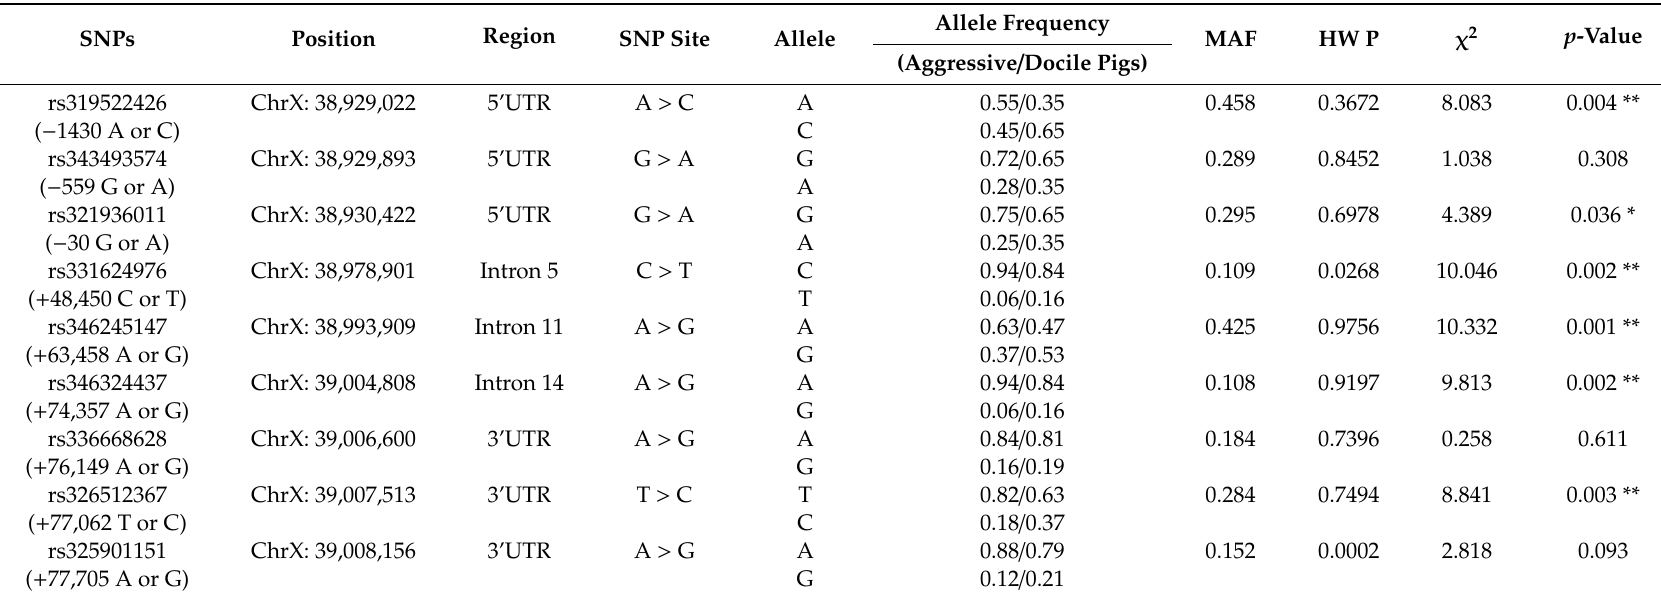
Table 2. The allele genotypes, frequencies, and significance of SNPs in the porcine MAOA gene between the most aggressive and the most docile